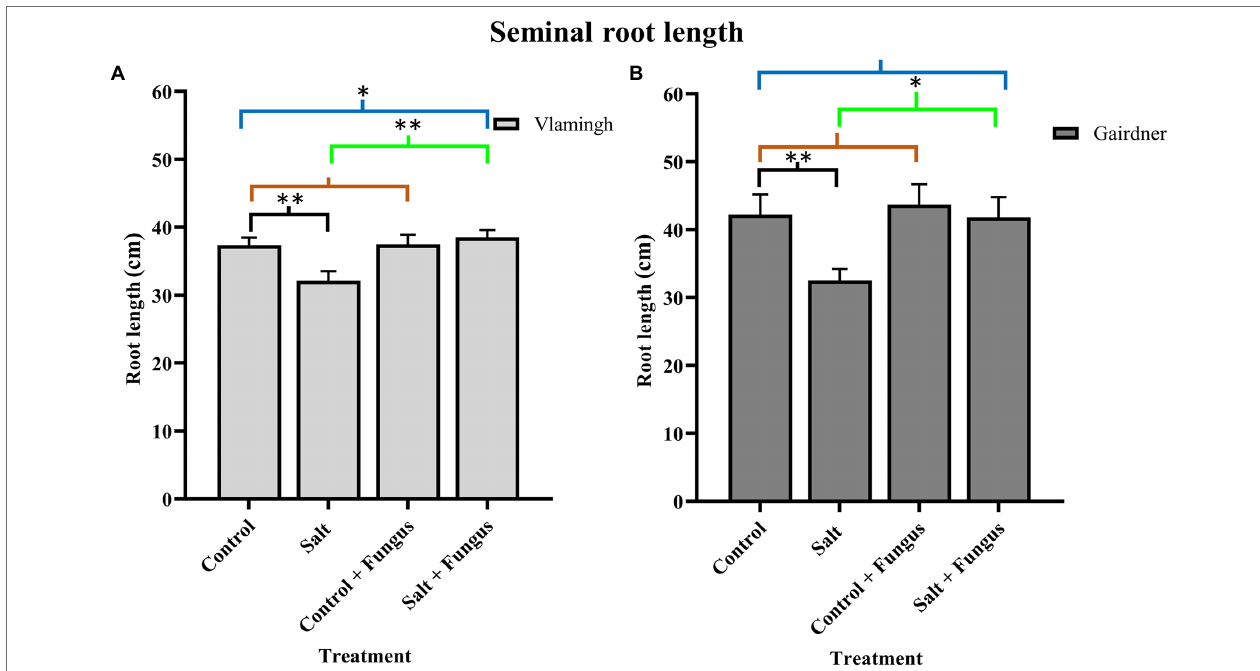
FIGURE 1 | Seminal root length of barley roots of two genotypes, cv. Vlamingh (A) and cv. Gairdner (B) under four treatment conditions for seedlings grown in soil. X axis represent treatments and Y axis represent lengths in cm. n = 6 for both genotypes. Different comparisons are represented by three colour bars above the graphs: black represents comparisons between salt and control, light brown represents comparisons between control + fungus and control, and cyan green represents comparisons between salt + fungus and salt. As established by Student’s t-test, asterisks imply significance for P < 0.05 (one asterisk) and p < 0.01 (two asterisks).